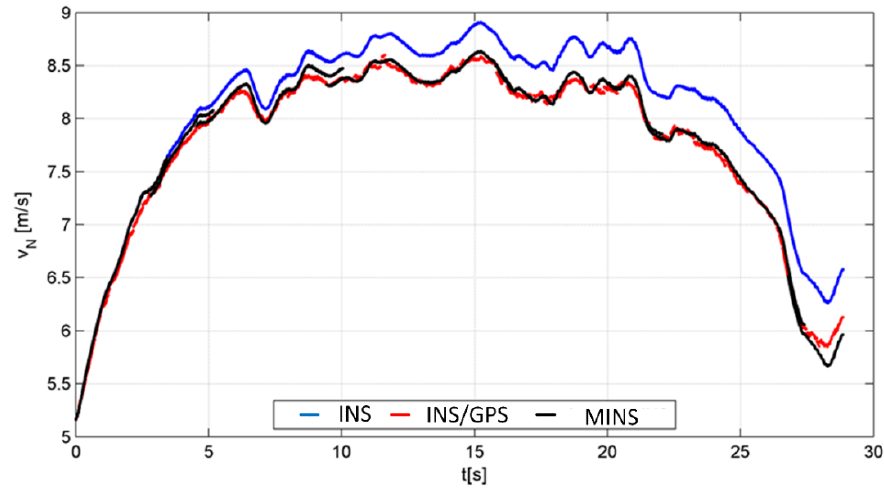
Figure 7. INS (blue), MINS (black), and INS/GPS (red) velocity, North axis.